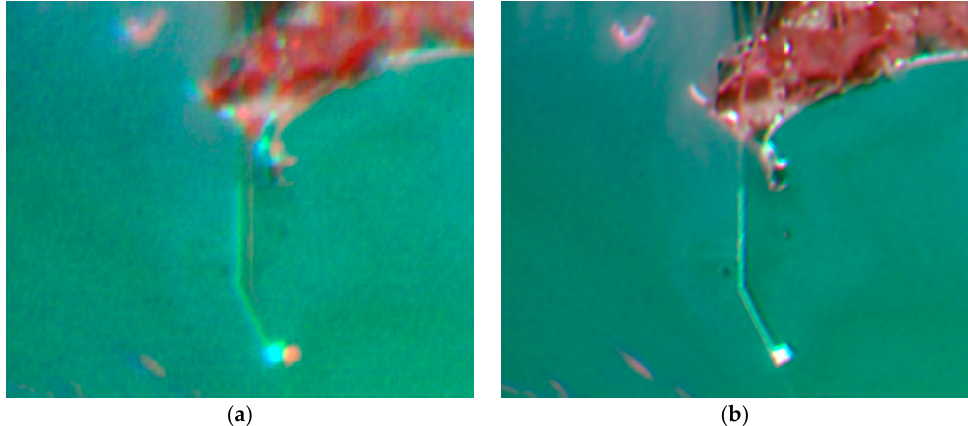
Figure 3. Comparison of an original GF-4 image ( a ) and the band-registered image ( b ).